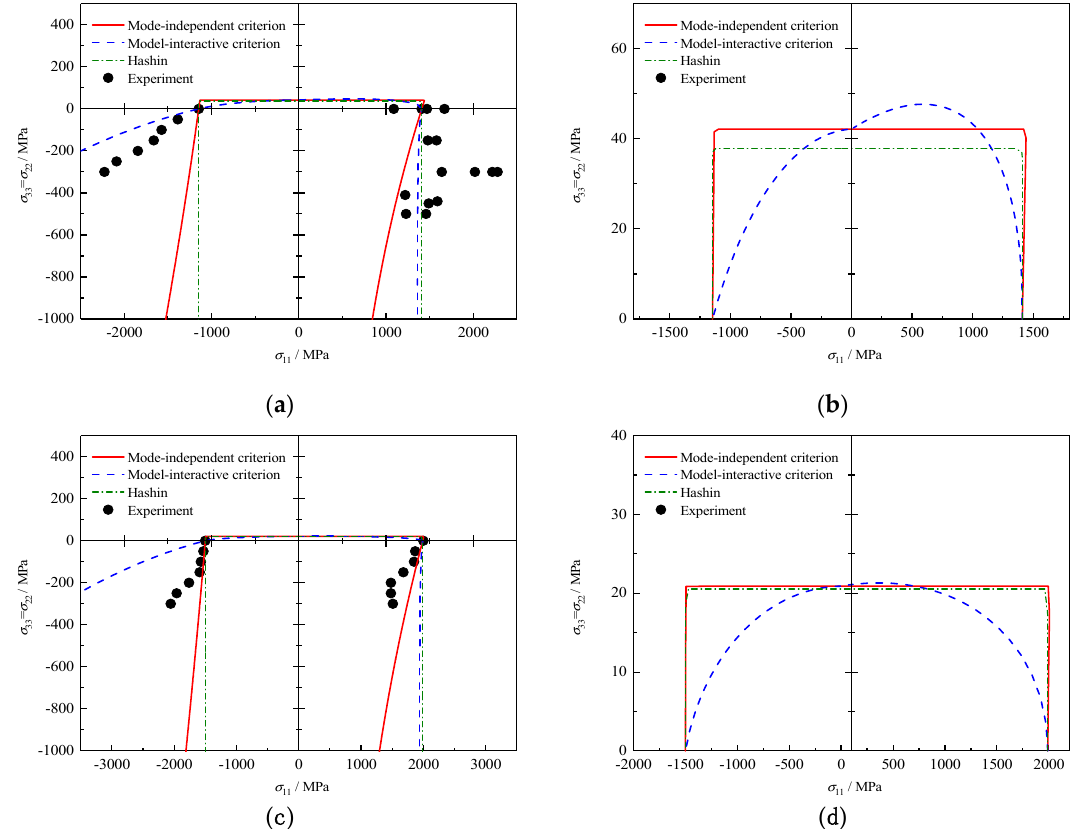
- σ σ (where = σ σ ) for S- 11 22 22 33